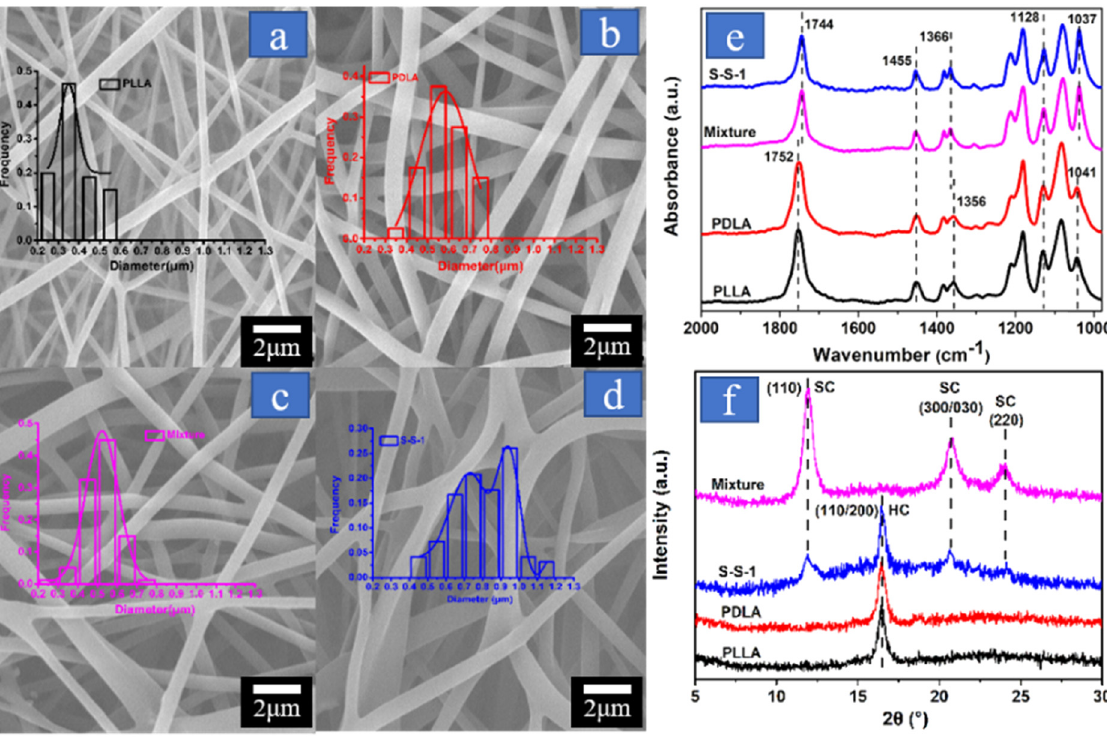
Figure 14: SEM micrographs and diameter distribution of ( a ) PLLA, ( b ) PDLA, ( c ) PLLA/PDLA mixture, and ( d ) S - S - 1 bicomponent nano fi bers. ( e ) FT - IR spectra of PLLA, PDLA, S - S - 1 bicomponent, and PLLA/PDLA mixture nano fi bers. ( f ) X - ray di ff raction pro fi les of PLLA, PDLA, S - S - 1 bicomponent, and PLLA/PDLA mixture nano fi bers. Reproduced with permission ( 137 ) Copyright Wiley - VCH Verlag GMBH & Co.